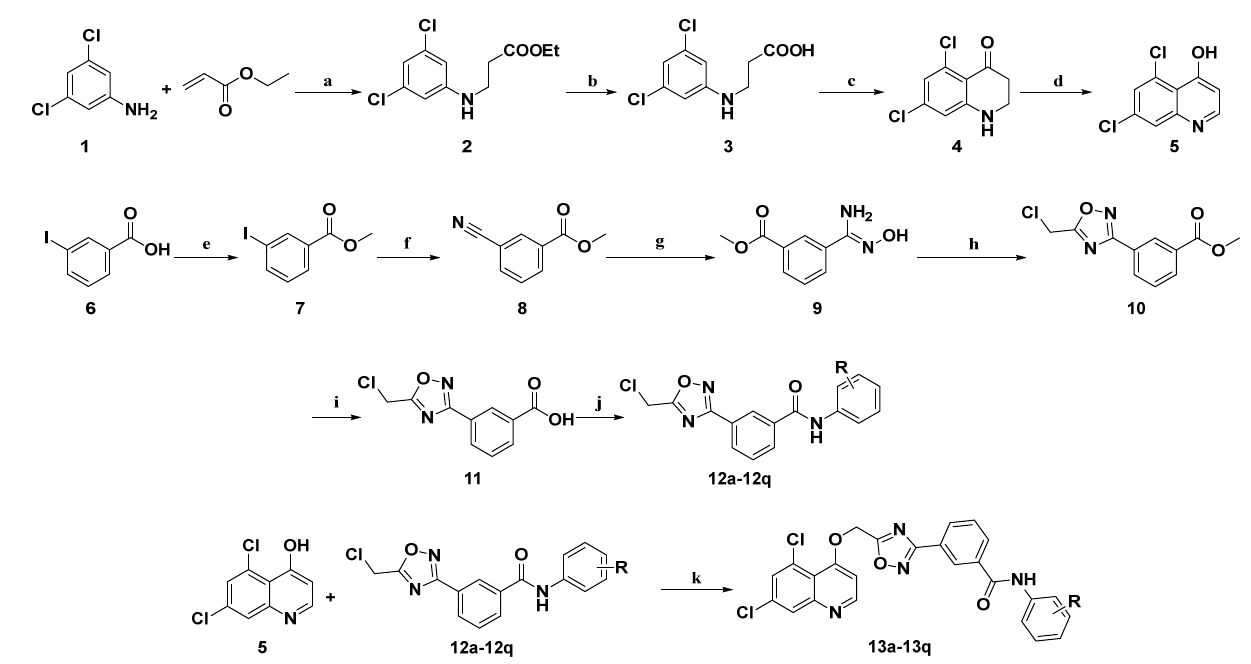
Table 1. Effects of reaction conditions on the synthesis of compound 5